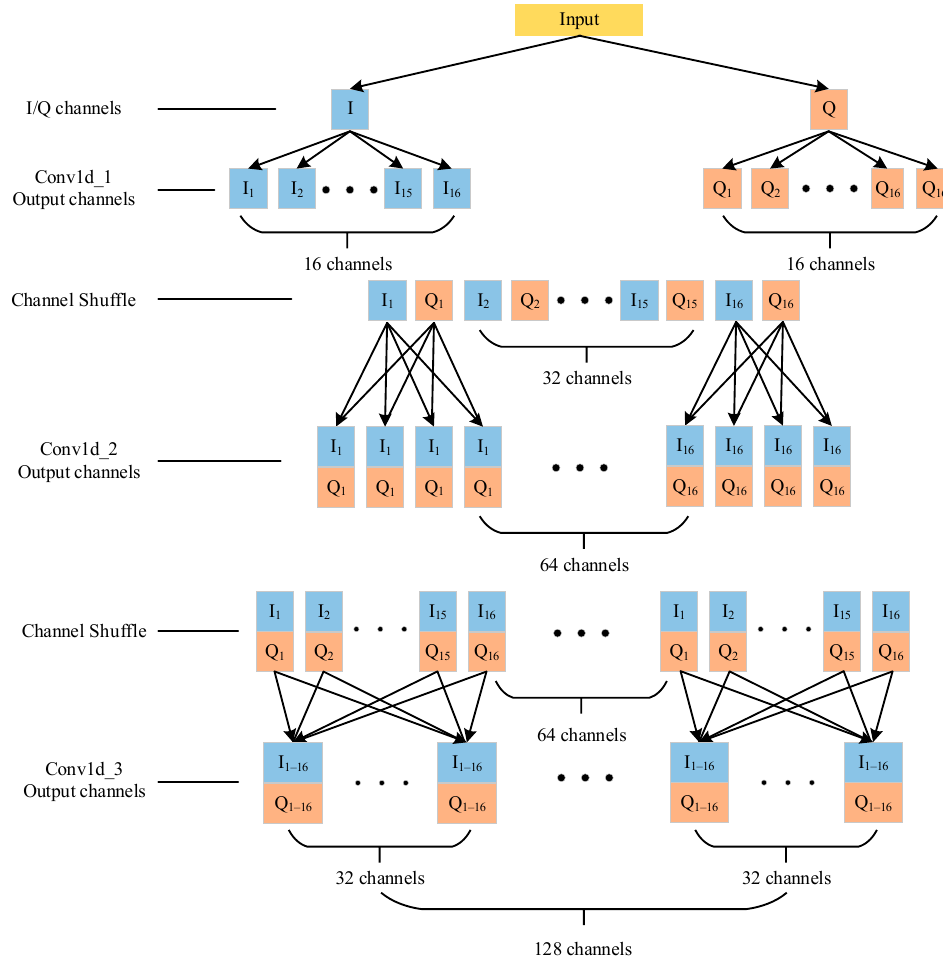
Figure 3. Schematic of group convolution and channel shuffle.